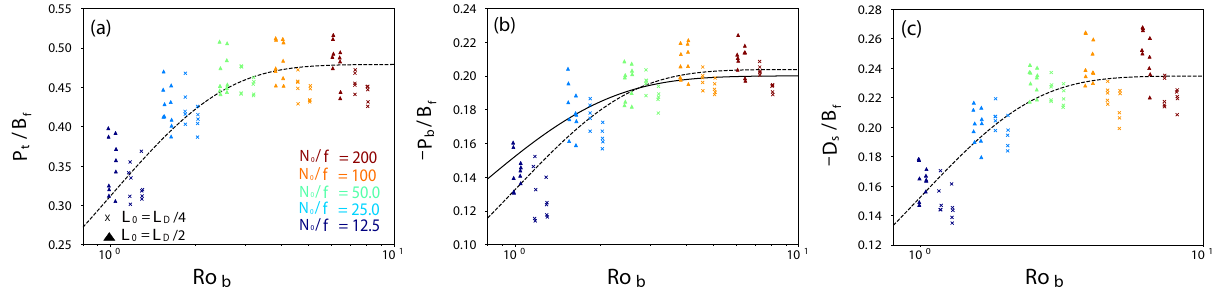
0 ) averaged D s in the pure CT simulations ( U 2 P b , and (c) − − ∗ =